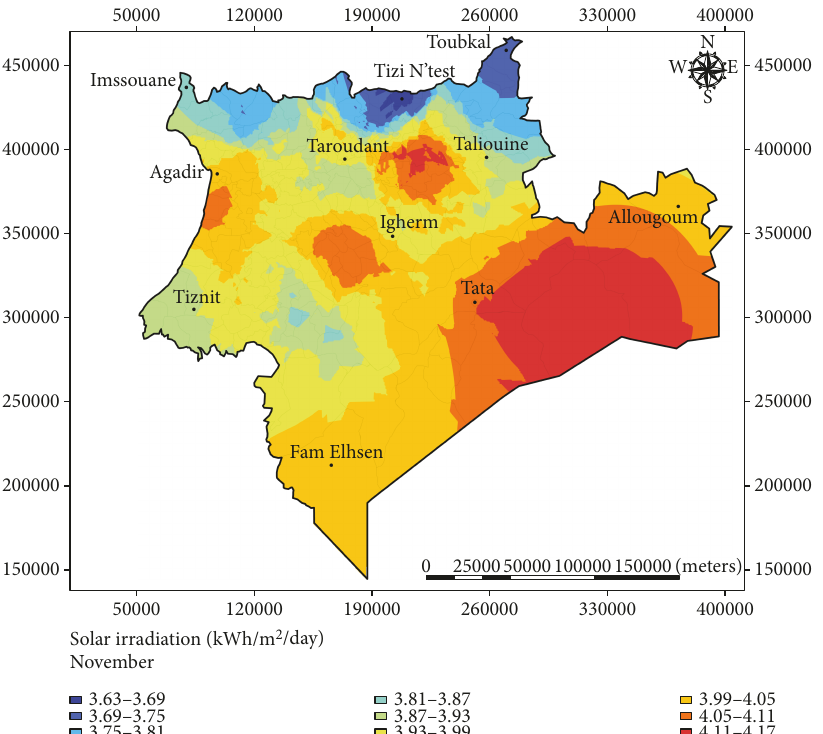
Figure 7: Solar energy potential map of the Souss-Massa area for the month of November as estimated by the ANN and designed with the Kriging interpolation technique.